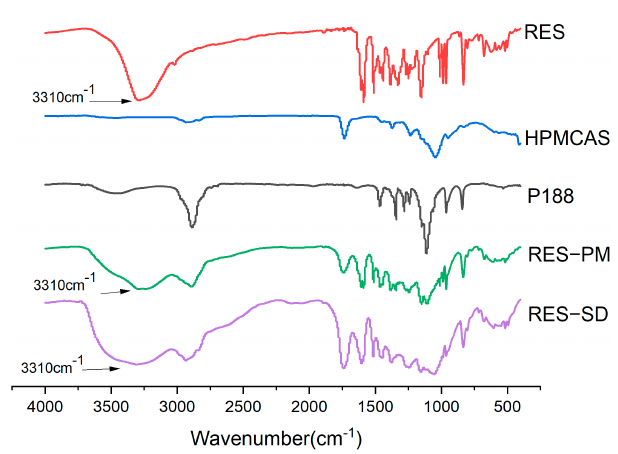
Figure 15. IR spectrum of PCE, carriers, PCE − PM and PCE − SD.